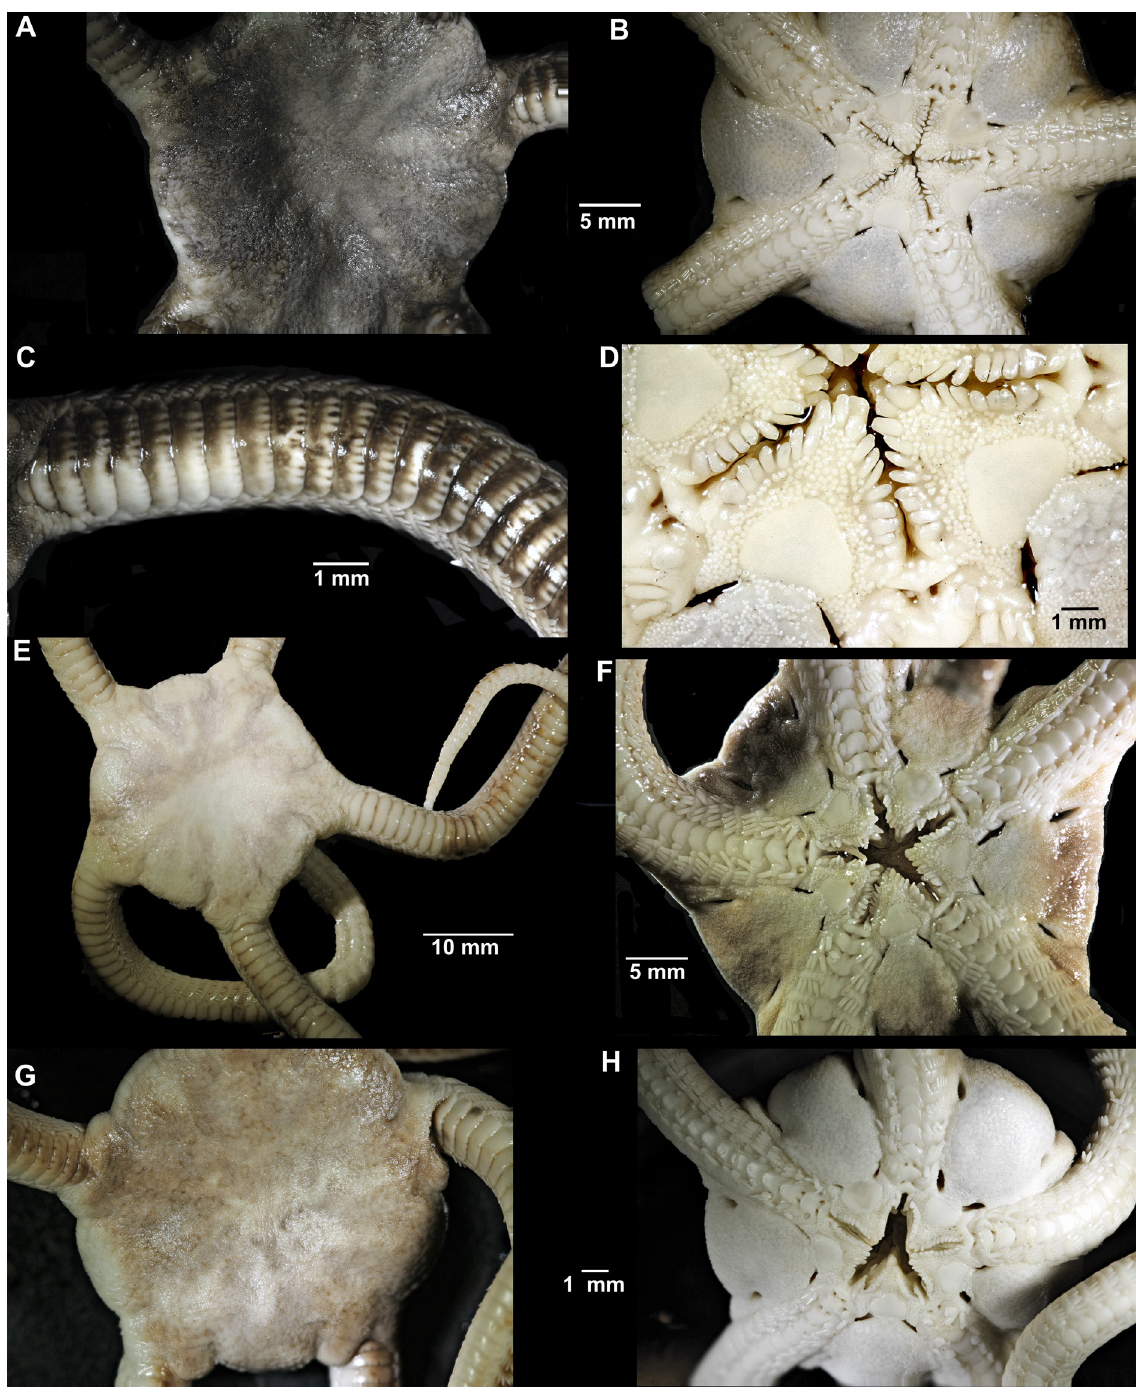
Fig. 4. Ophioderma guineense Greef, 1882, type specimens, digital images. A – D . Lectotype (ZMH E8315). A . Dorsal disc. B . Ventral disc. C . Dorsal arm. D . Jaws. – E – F . Paralectotype (ZMH E1686). E . Dorsal aspect. F . Ventral aspect. – G – H . Other paralectotype (ZMH E1686). G . Dorsal aspect. H . Ventral